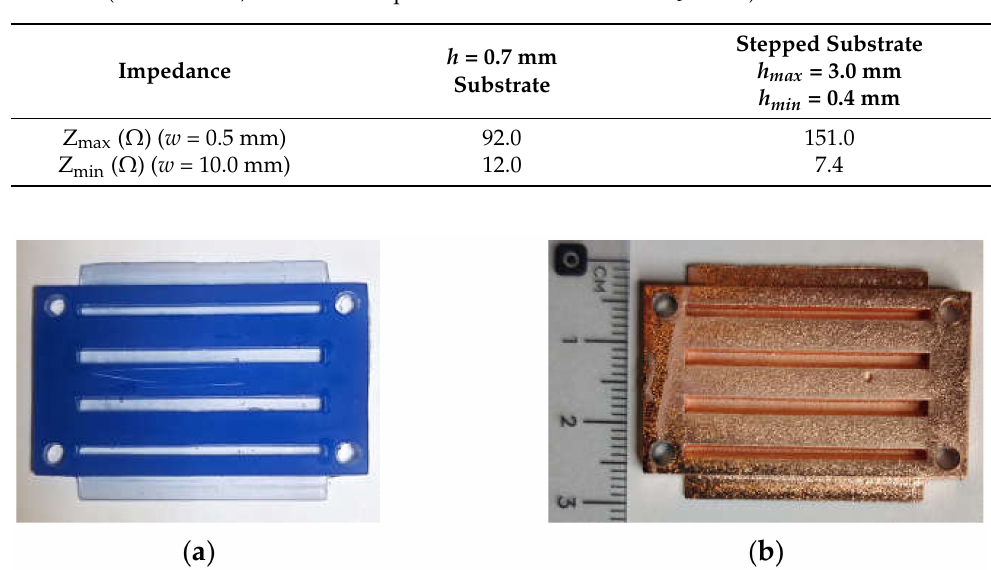
Table 3. Characteristic impedances achievable for a constant height substrate and for the stepped substrate (in both cases, substrates are printed with the resin with ε r = 3.25).